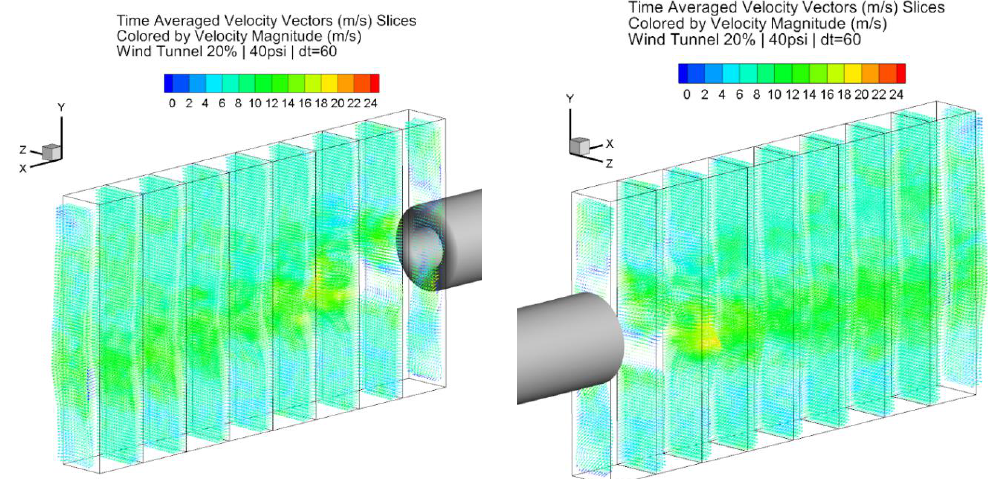
Figure 17. Time-averaged 3D velocity vector slices for the 20% freestream and 40 psi vortex pressure case from two perspective views.